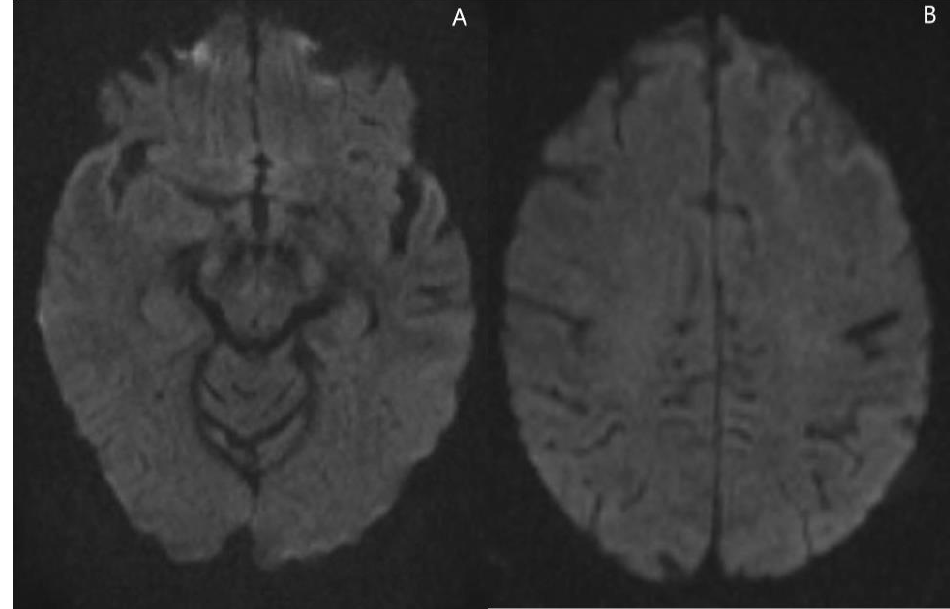
Figure 3. ( A,B ) Axial diffusion-weighted MRI demonstrating no restricted diffusion of the dominant right temporal and left frontal lesions. The other lesions (not shown) demonstrated no restricted diffusion.